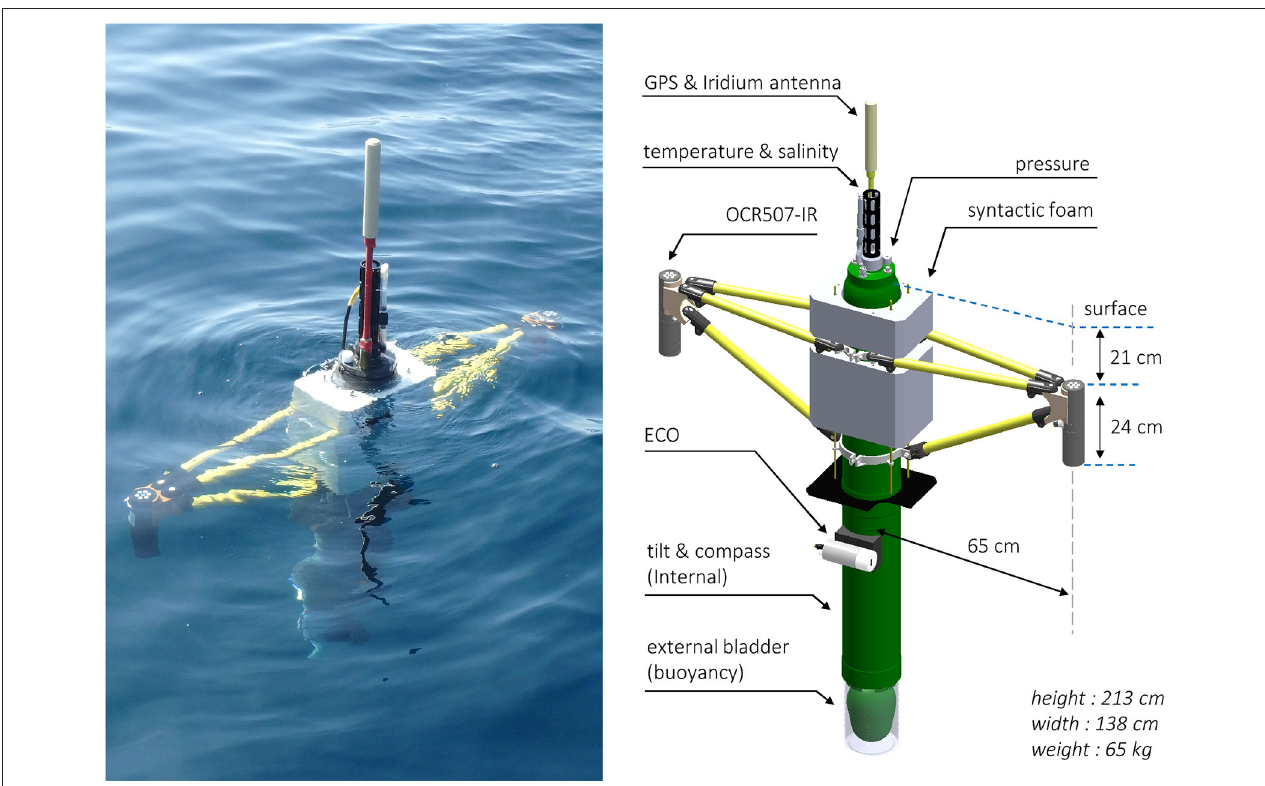
FIGURE 1 | Left, ProVal float at surface during deployment in the Mediterranean Sea (photo courtesy of N. Mayot). Right, technical drawing. Radiometers are mounted at 65cm (inter-axial) from the float hull. In “buoy” mode, radiometers are at 21 and 45cm depth, respectively, for irradiance and radiance